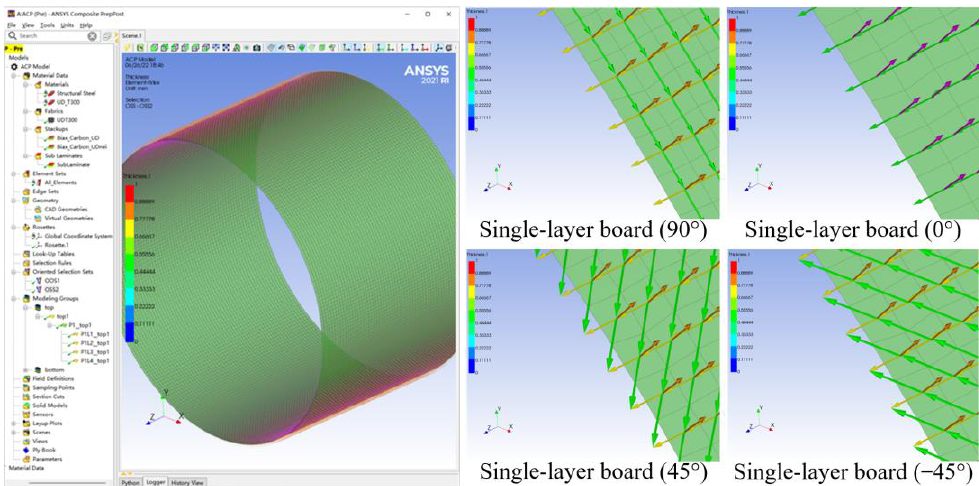
Figure 4. Laminate model in the ACP module.